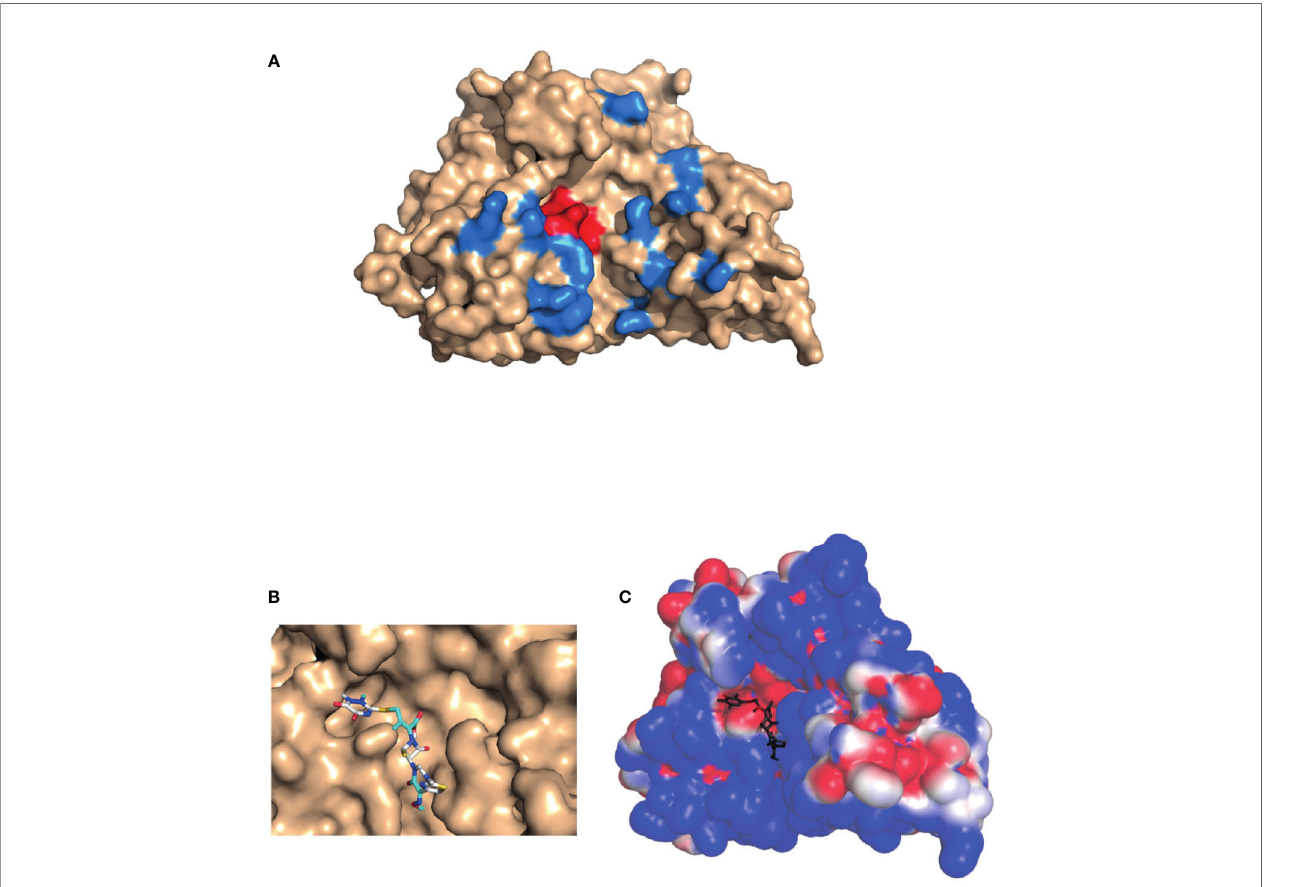
FIGURE 1 | Artemis protein docking. 3-D structure of the catalytic domain of SNM1C/Artemis af fi nity with b -lactam antibiotics (PDB: 6WO0) (35). (A) Location of the b -lactamase conserved active site shown in red, and of the putative DNA-binding site in the pocket III (described by Karim et al. shown in blue. (B) Predicted binding of ceftriaxone to the SNM1C/Artemis target within its conserved active site. Molecular docking was performed using the AutoDockTools software. (C) Electrostatic potential surface of Artemis with predicted docking of ceftriaxone. An electrostatic potential surface of SNM1C/Artemis protein was generated using the PyMOL1.8.0 software along with the APBS tool plugin. The red color indicates an excess of negative charges near the surface and the blue color arises from a positively charged surface. The ceftriaxone scaffold is shown in dark